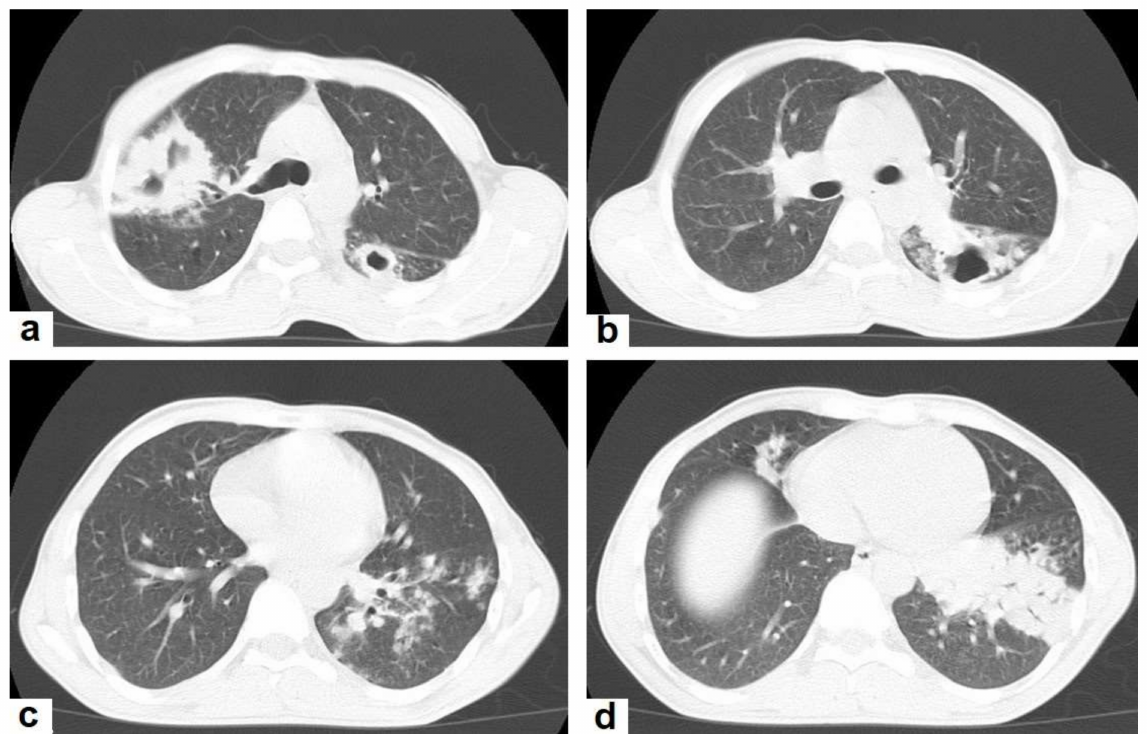
Figure 3. Post primary TB in a 45-year-old male with cough and hemoptysis. Axial images of chest CT show ( a ) cavitary lesions in the right upper lobe and upper segment of the left lower lobe surrounded with consolidation, ( b ) cavitary lesion in the upper segment of the left lower lobe with thick irregular wall surrounded by patchy ground glass opacities, ( c ) centrilobular nodules and tree-in-bud nodules, and ( d ) consolidation in the left lower lobe with